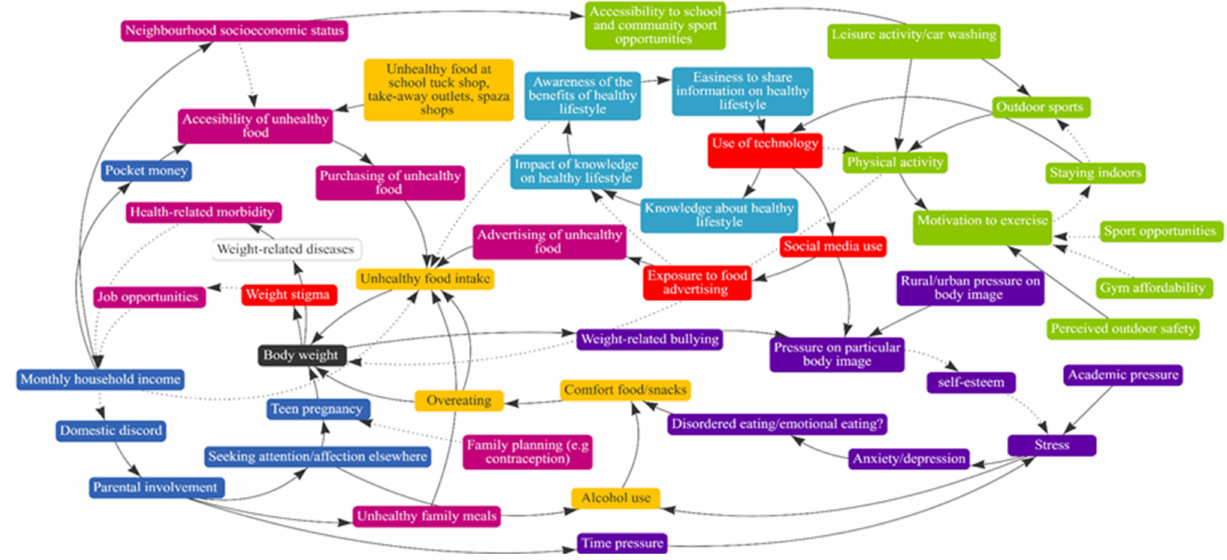
Figure 1. Combined map representing the perceptions of young people of the drivers of obesity in four South African